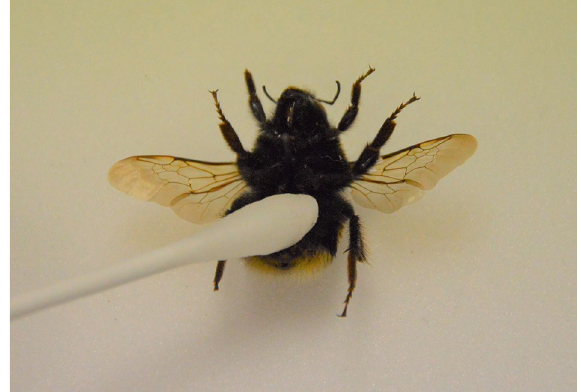
Figure 5. Application of the proposed extraction method on the Bombus terrestris